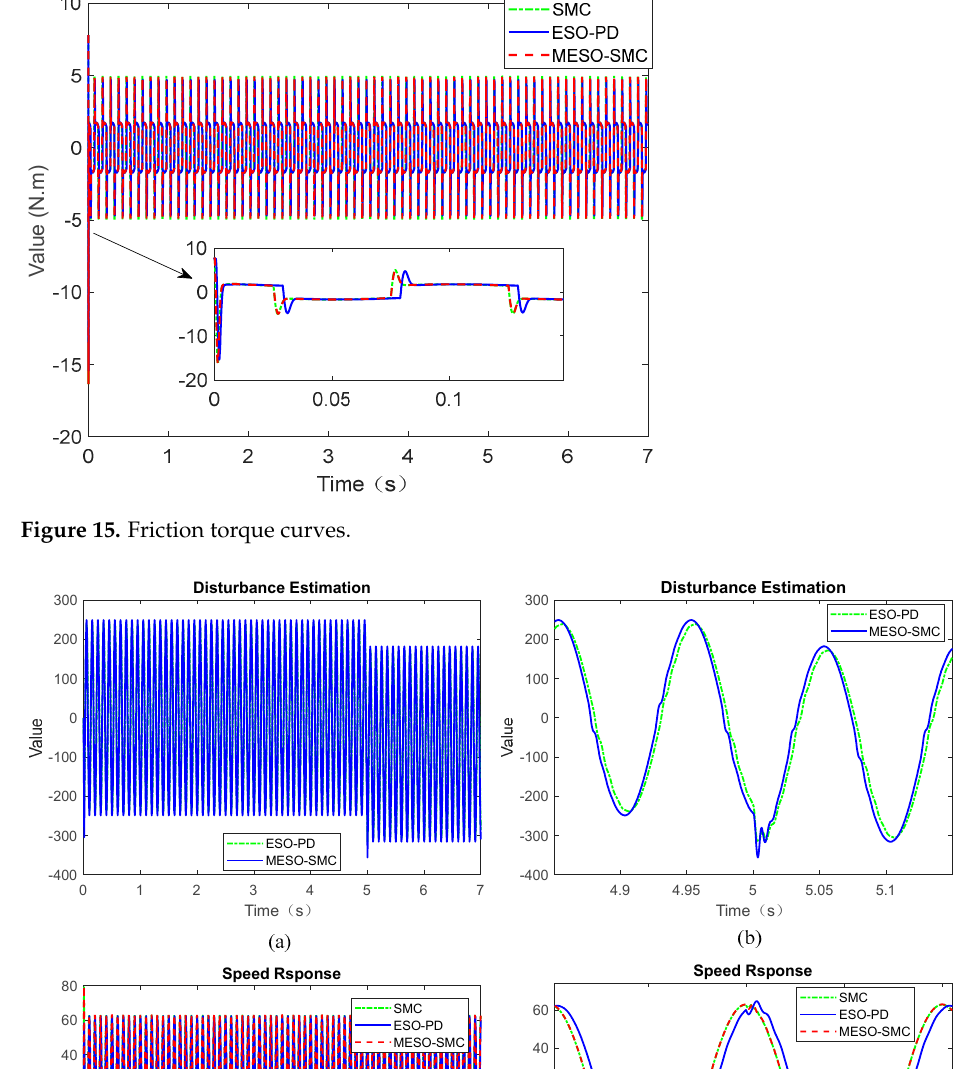
16 of 19 Figure 14. High-frequency dynamic simulation comparisons. ( a ) Position tracking. ( b ) Local curves of ( a ). ( c ) Control voltage. ( d ) Local curves of ( c ). As shown in Figure 14a,b. Considering friction nonlinearity, hinge torque load has little influence on the control accuracy of the EMA system under simulation conditions,